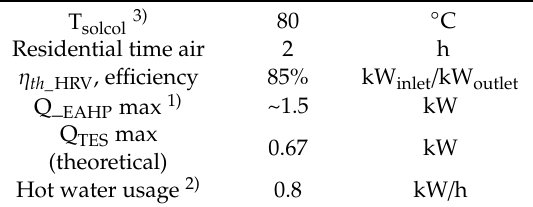
Table 2. House heating and ventilations system data.